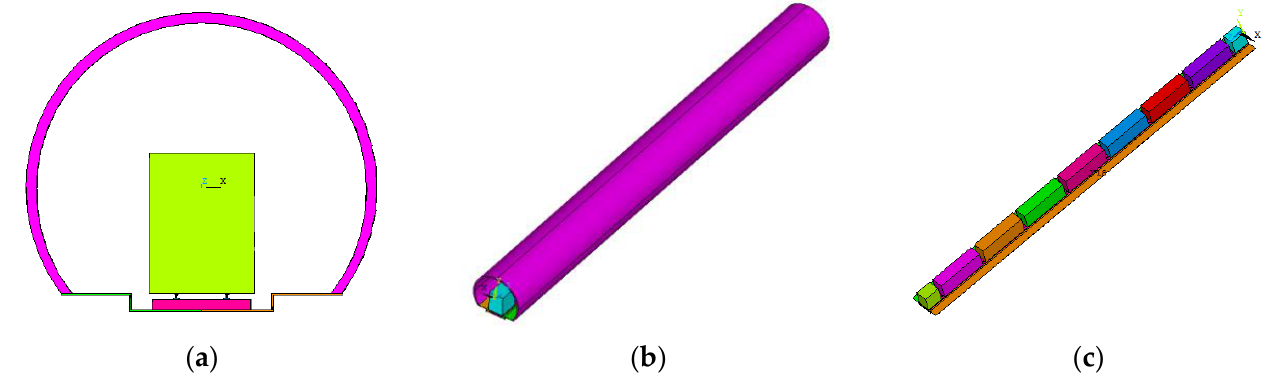
Figure 9. Screenshot of the model: ( a ) cross section of the model; ( b ) overall view of the model; ( c ) carriage layout of the model.